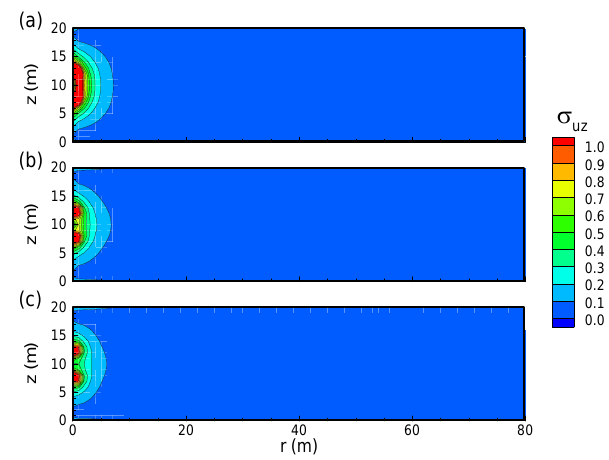
Fig. 6. The solutions of velocity standard deviation for z -direction at t = 80day: (a) r -correlation length ( λr )=1.0m, (b) r -correlation length ( λr )=5.0m, and (c) r -correlation length ( λr ) =10.0